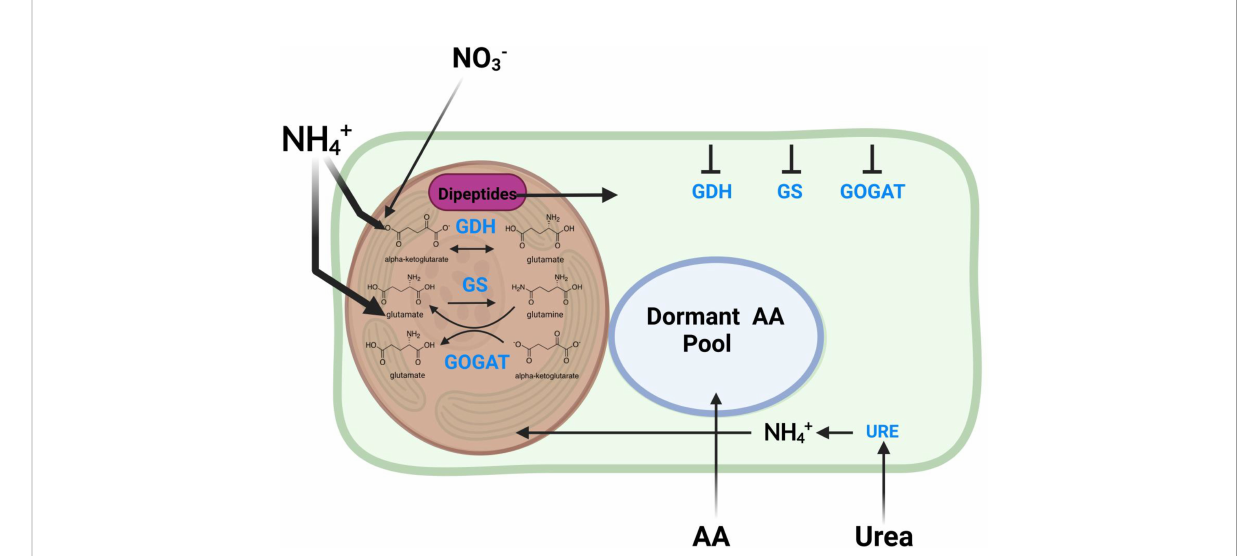
FIGURE 6 Proposed schematic of the mechanism for nitrogen assimilation in scleractinian corals. The schematic proposes the ways major nitrogen sources are incorporated in the coral holobiont. Glutamate dehydrogenase (GDH), glutamine synthetase (GS), and glutamine oxoglutarate aminotransferase (GOGAT) enzymes needed for nitrogen incorporation are found in both the host coral animal and the Symbiodiniaceae, but are likely less active in the host organism than in the Symbiodiniaceae. These enzymes produce glutamine and glutamate as precursors for the production of the remaining downstream amino acids. There is a rapid and dynamic incorporation of amino acids into dipeptide products immediately after production before they are assimilated into the more stable amino acid